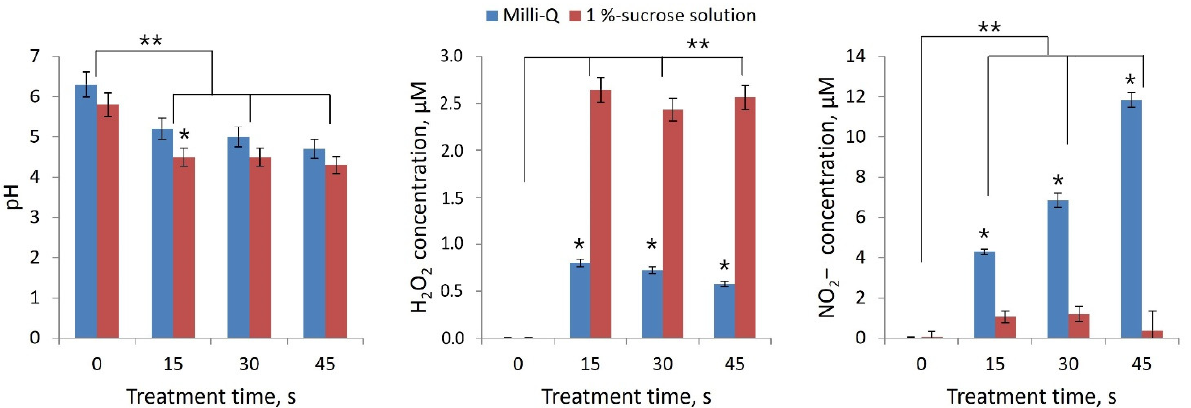
Figure 6. Change in pH and generation of H 2 O 2 and NO 2 − when DBD CAP was exposed to Milli-Q water and aqueous sucrose solution (1%) for 15, 30, and 45 s. Number of independent experiments was 5. * indicates a significant difference at 5% level in comparison with Milli-Q group with 1%-sucrose solution group at same treatment time ( p < 0.05, Mann – Whitney U test). ** indicates a significant difference at 5% level in comparison with the control (treatment time 0 s) ( p < 0.05, ANOVA). Data are presented as mean values and standard errors of the mean.